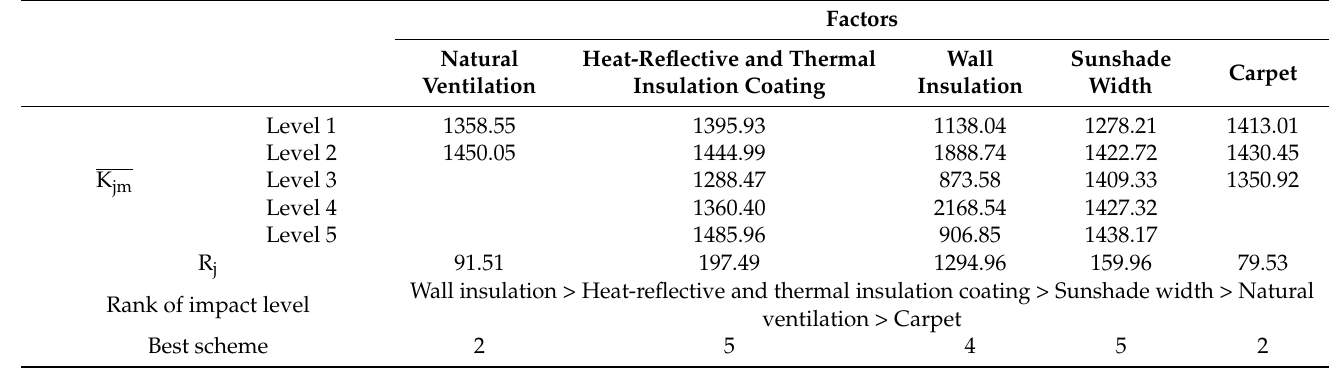
Table 9. Sensitivity analysis of the energy